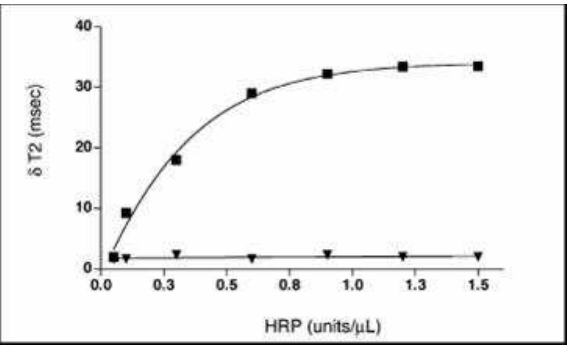
Figure 12. Effect of Horse radish peroxidase concentration on d T2 ( Reprinted from [27] with permission from ACS